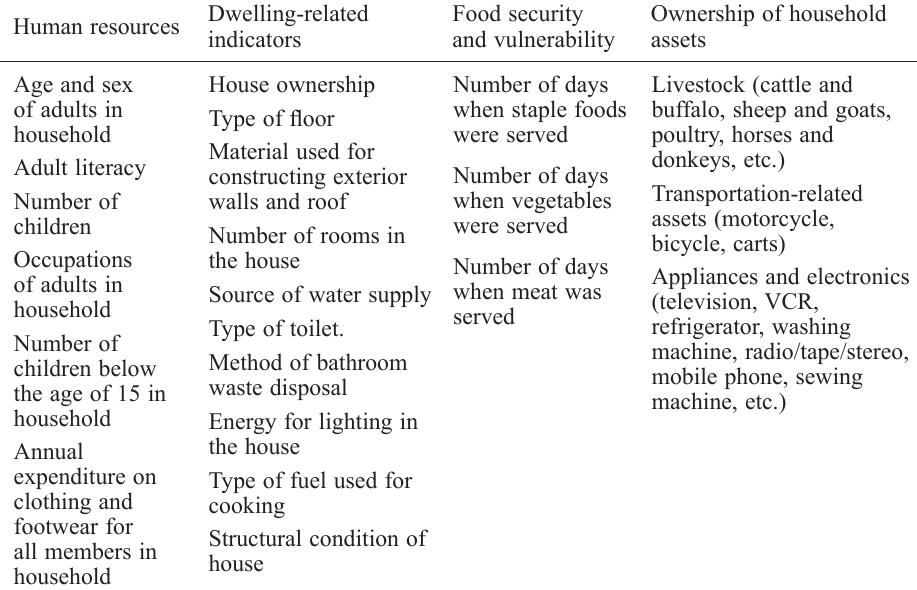
Table 1 . Final list of variables used to construct the poverty